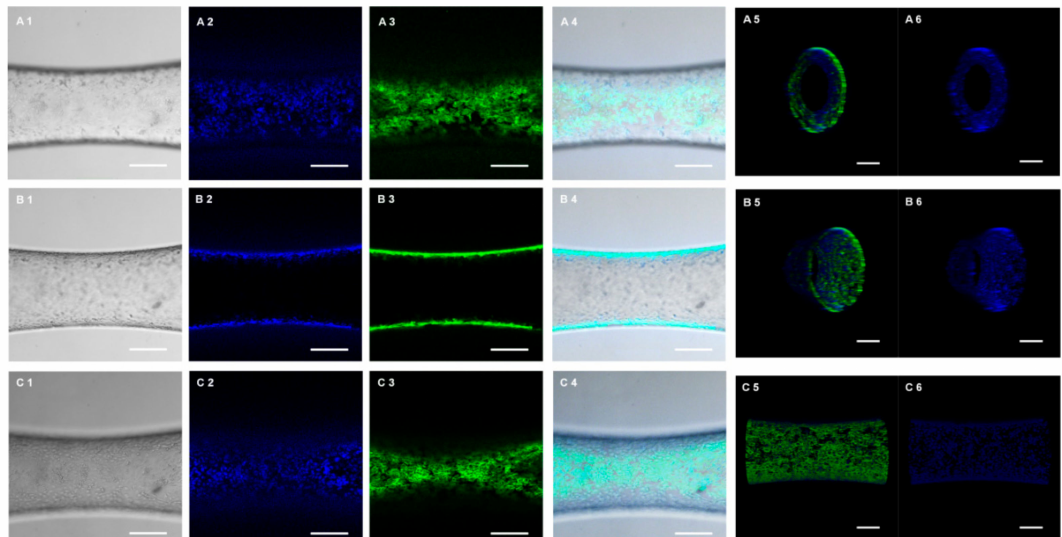
Figure 5. Cytoskeleton and nuclei double staining, showing the endothelialization of microvessel in the microfluidic chips. Confocal fluorescence microscopy images, showing the bottom ( A1 – A4 ),